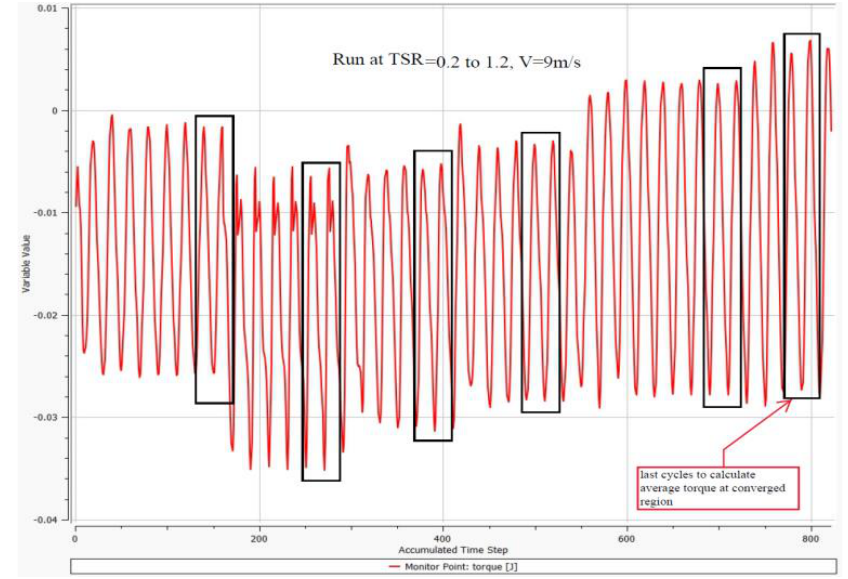
Figure 9. Torque variation against the accumulated time step.